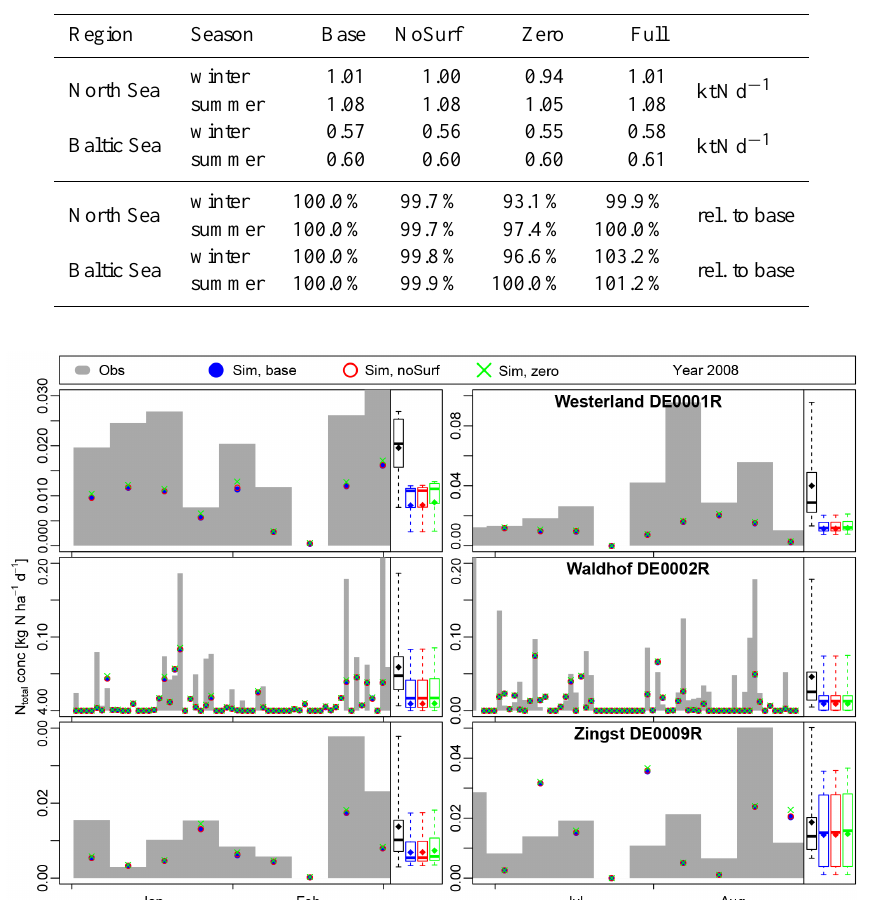
Figure 10. Similar to Fig. 6 but showing nitrogen (reduced and oxidized) deposition (kgNha − 1 d − 1 ). The different interval length is due to different measurement intervals at the individual